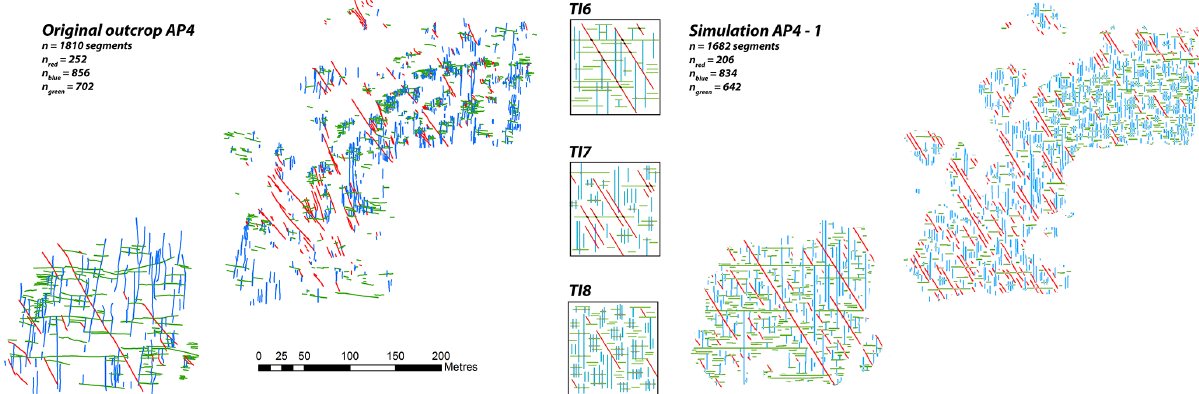
Figure 12. Comparison of the AP4 original outcrop with a MPS simulated version AP4-1.